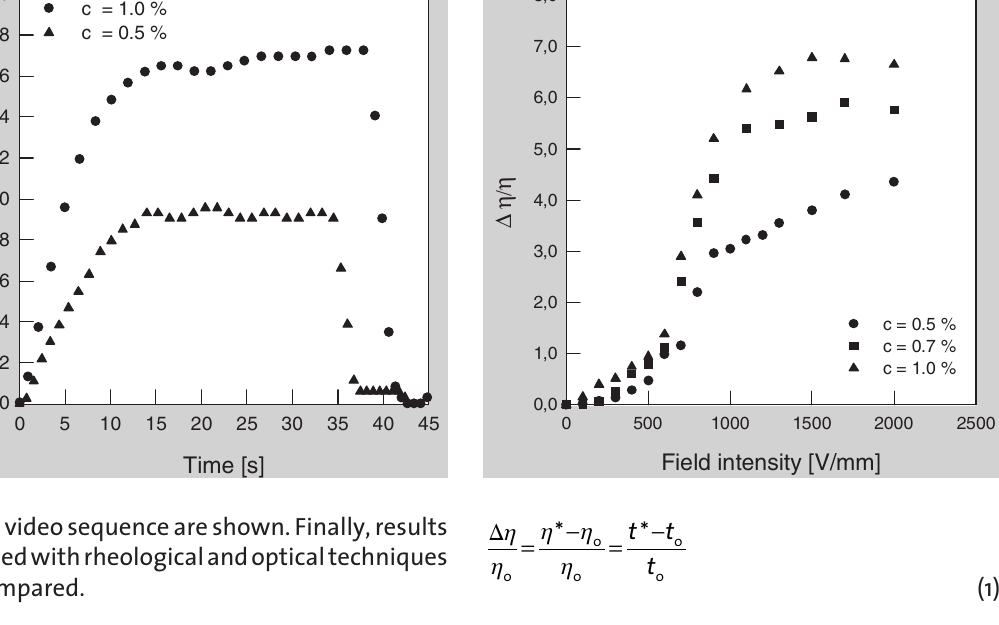
Figure 1 (left): Relative viscosity changes for the 0.5 % and 1 % concentration samples when an electric DC field of 600 V/mm is turned on for a period of 30 and 40 seconds respectively. Figure 2 (right): Effect of field strength on the relative viscosity for three concentrations of cornstarch in silicone